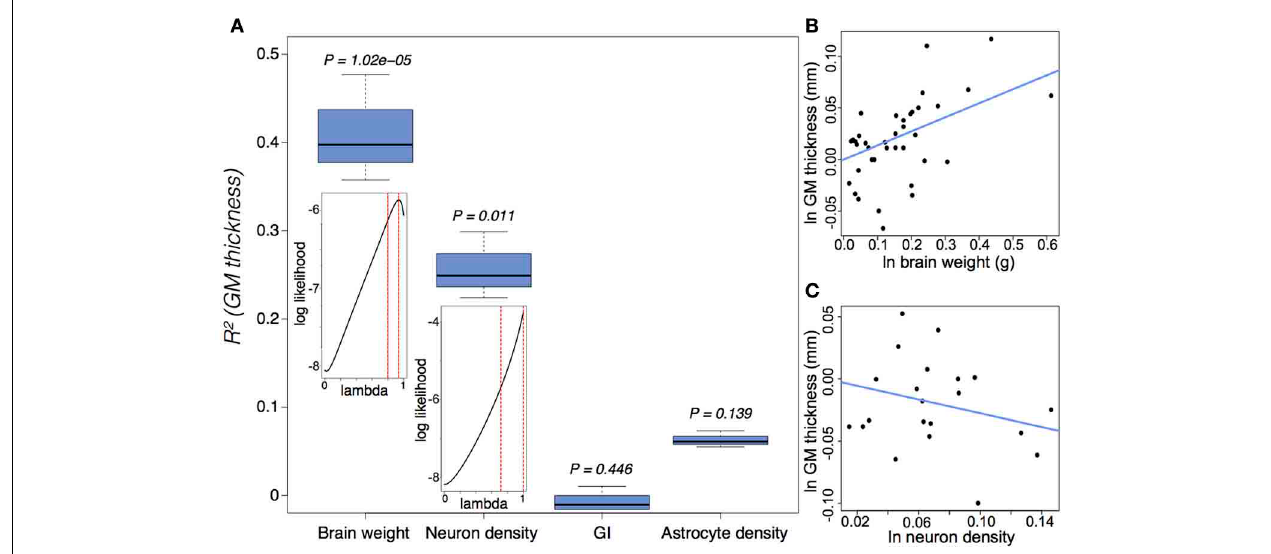
FIGURE 6 | Gray matter (GM) thickness is a function of brain weight and neuron density. (A) Variation in GM thickness can be significantly explained by brain weight [ F ( 2 , 37 ) = 22 . 58, P = 3 . 9 × 10 − 7 ] and neuron density [ F ( 2 , 20 ) = 7 . 96, P = 0 . 003], but not by either GI [ F ( 2 , 38 ) = 0 . 066, P = 0 . 936] or astrocyte density [ F ( 2 , 20 ) = 2 . 37, P = 0 . 119]. The insets suggest a strong phylogenetic signal (Pagel, 1999), tantamount to a random walk, in the scaling of GM thickness as a function of brain weight (lambda = 0 . 89 ( + 0 . 07 ) ( − 0 . 09 ) )